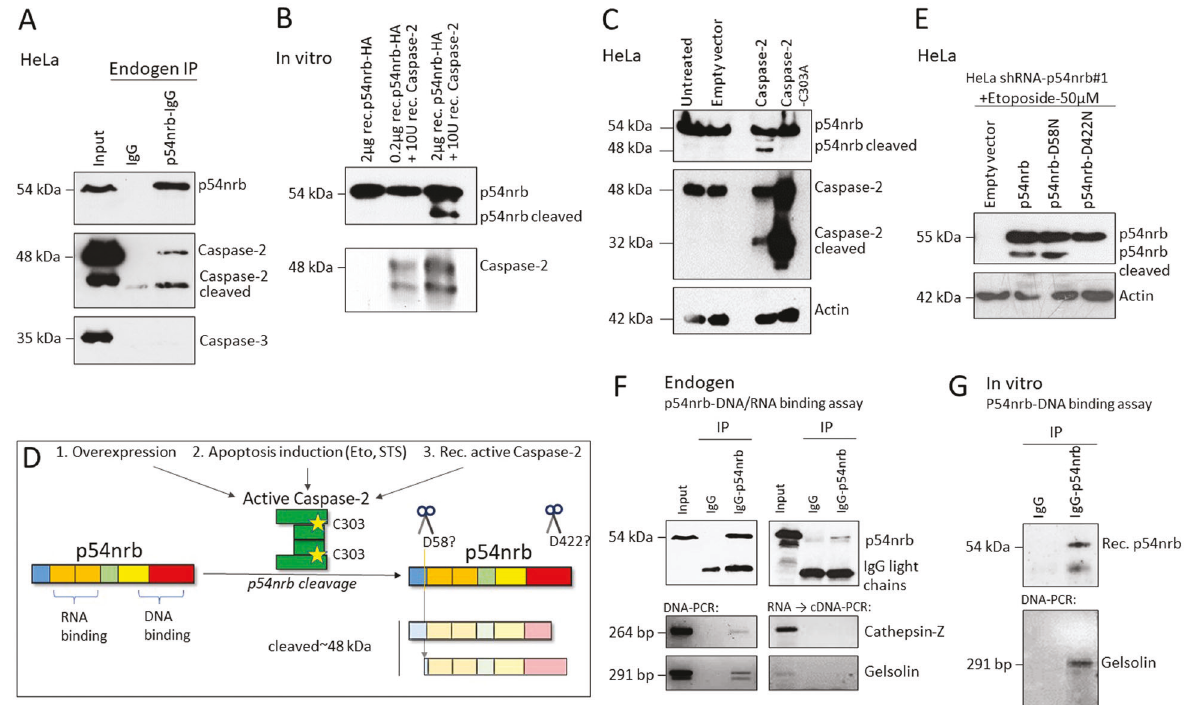
Fig. 5 Caspase-2 directly interacts with p54nrb and cleaves p54nrb at D422. A Immunoblot of p54nrb caspase-2 and caspase-3 after endogenous immunoprecipitation (IP) of p54nrb from HeLa cells. B Immunoblot of p54nrb and caspase-2 after in vitro caspase cleavage assay with 0.2 µg or 2 µg recombinant p54nrb and 10 U human recombinant active caspase-2 after 3 h incubation at 37 °C. C Immunoblot of p54nrb cleavage and caspase-2 from HeLa cells at 48 h after ectopic expression of 1 µg/ml empty vector pcDNA3-Flag, pcDNA3-caspase-2-Flag, and pcDNA3-caspase-2-C303A-Flag (inactive). D Graphical illustration of p54nrb cleavage by activated caspase-2 via either overexpression, apoptotic induction, or recombinant caspase-2 protein. The active site of caspase-2 dimer is marked with yellow stars. Location of the putative cleavage sites in the p54nrb protein domains are marked with arrows, and its anticipated cleavage fragments are shown. E Immunoblot of p54nrb cleavage in HeLa shRNA-p54nrb#1 cells after ectopic expression of pcDNA3-Flag, pFlag-p54nrb, pFlag-p54nrb-D58N and